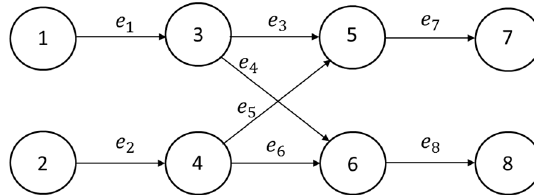
Figure 11. Multi-time window and multi-service network. Table 16. Basic information of each arc.